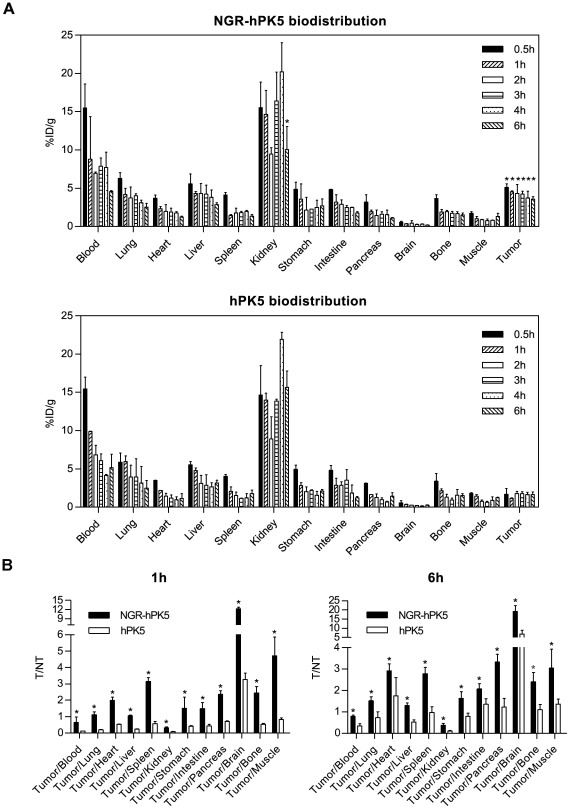
Biodistribution analysis of hPK5 and NGR-hPK5 in tumor-bearing mice.When the LLC tumor volume reached about 300–400 mm3, 99 mTc-labeled hPK5 or NGR-hPK5 (500 µCi) were injected i.v. into LLC grafting C57BL/6J mice. Tumor, blood and major organs were collected, weighed and counted on a gamma counter at 0.5, 1, 2, 3, 4 and 6 hours post-injection. A
, The biodistribution of 99 mTc-labeld NGR-hPK5 and hPK5 in tumor, blood and normal organ (lung, heart, liver, spleen, kidney, stomach, intestine, pancreas, brain, bone and muscle) at 0.5, 1, 2, 3, 4 and 6 hours post-injection. The organ uptake was calculated as the percentage of injected dose per gram of organ tissue (%ID/g). The tumor uptake of NGR-hPK5 was significantly higher (p<0.05) than that of hPK5. No statistically significant difference has been found in their respective distribution in other tissues except for kidney in which the level of NGR-hPK5 was lower than that of hPK5 at 6 h. N = 3. B
, The tumor-to-normal tissue ratios of NGR-hPK5 and hPK5 at 1 h and 6 h post-injection were calculated from A. * p<0.05 compared with hPK5.